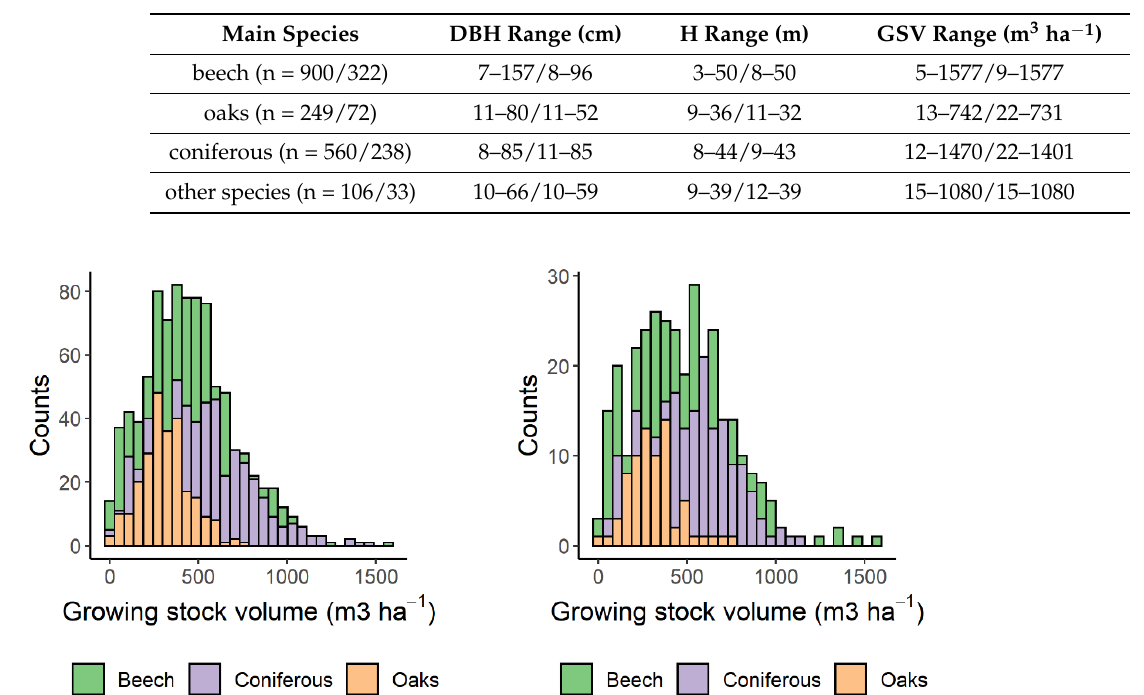
Figure 2. Growing stock volume distribution for all sample plots ( left ) and plots used for SAR-GSV modelling ( right ).